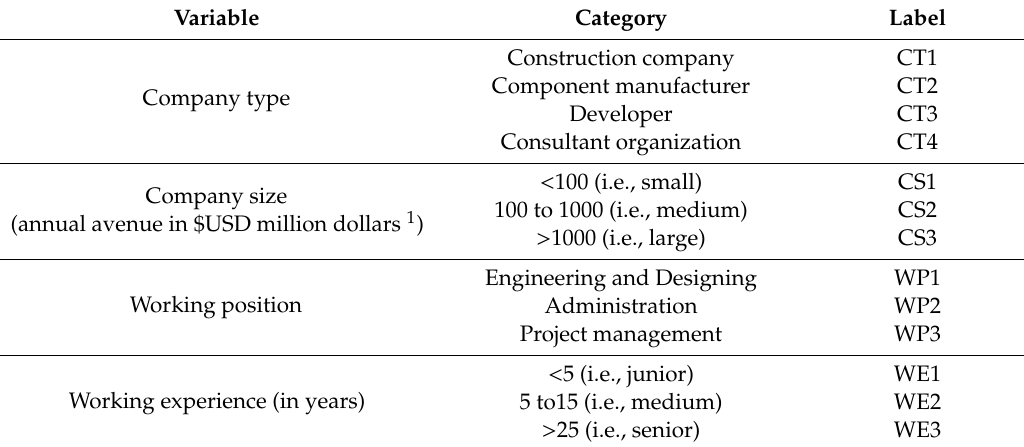
Table 1. Predictor variables and corresponding